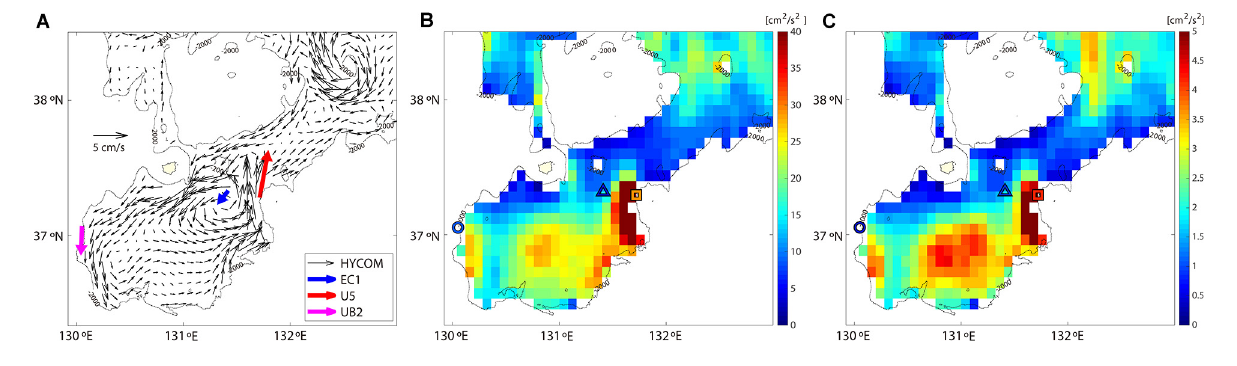
at 2000 m at U5, indicating bottom intensification. The mean and fluctuating currents (particularly at the longer intraseasonal band) are intensified at U5 on the eastern side near Dokdo, indicating eastward